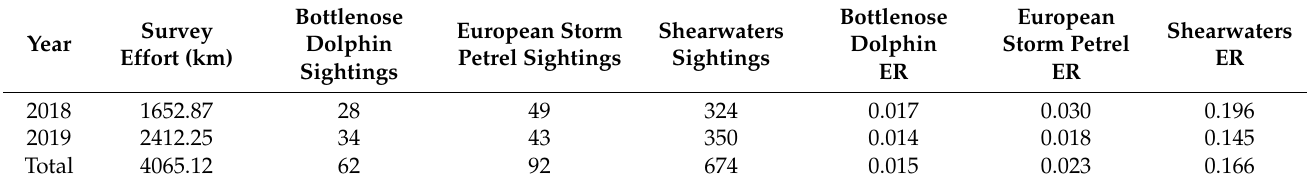
petrel) calculated as a ratio of the number of sightings and the survey effort (km covered).